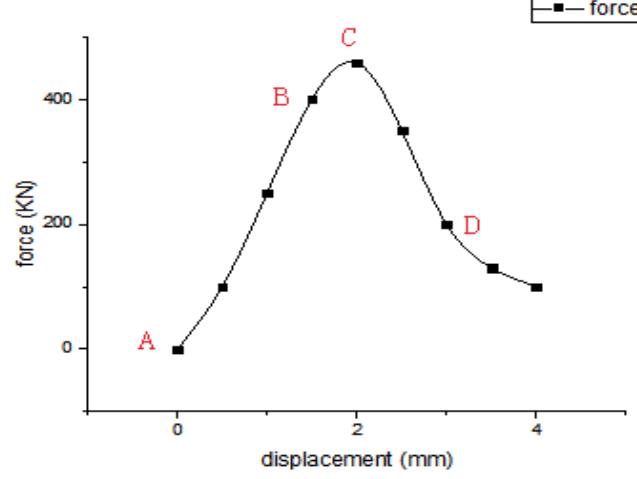
Figure 8. Twenty-eight day cube specimen failure curve.